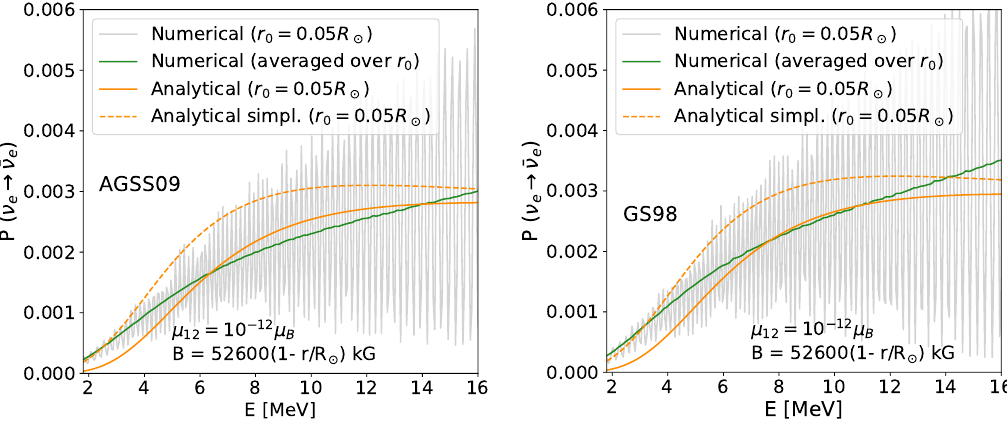
Figure 1 . Comparison of different calculations for ¯ ν eR appearance probability for 8 B neutrinos. Values of the oscillation parameters ( sin 2 θ 12 , ∆ m 2 ) = (0.32, 7.5 × 10 − 5 eV 2 ) and sin 2 θ 13 = 0 . 022 [29] 21 were chosen. Left and right panels correspond to AGSS09 and GS98 SSM, respectively [27]. Grey curves: numerical calculations assuming that all neutrinos are produced at r 0 = 0 . 05 R (cid:12) . Green curves: numerical calculation with averaging over the neutrino production region. Orange curves: results based on the full analytical expression (3.1) (solid) and on the simplified analytical expression